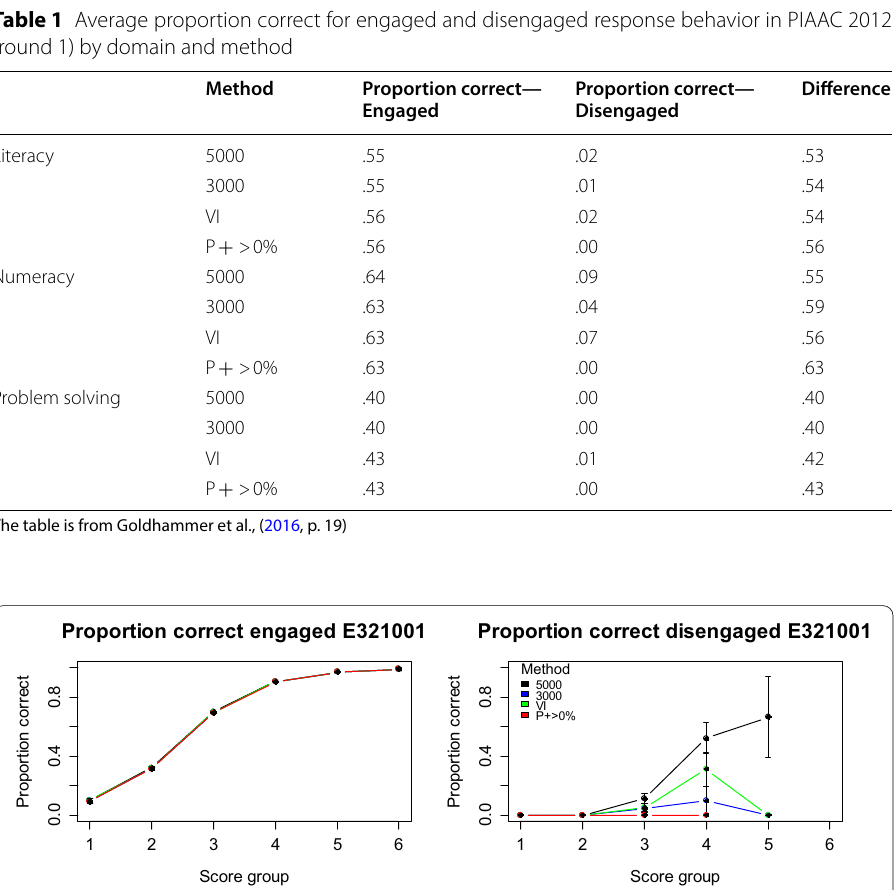
Table 1 Average proportion correct for engaged and disengaged response behavior in PIAAC 2012 (round 1) by domain and method